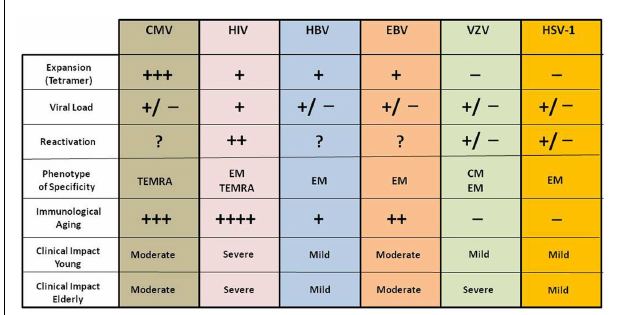
FIGURE 2 | Impact of different chronic viral infections on the immune system and clinical consequences in young and elderly subjects .The immunological and clinical impact of these viral infections is different in young and elderly and even among elderly; however they present a persistent antigenic stimulation throughout